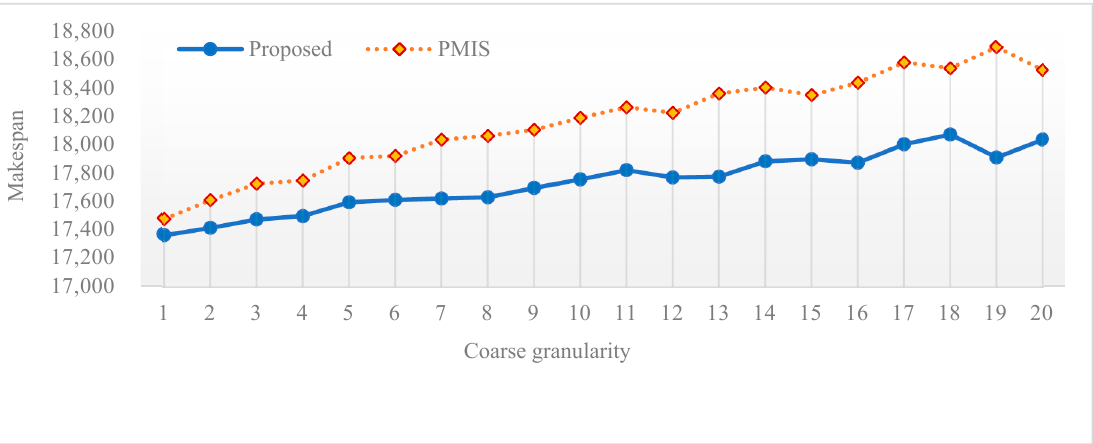
Figure 4. Makespan versus coarse granularity.